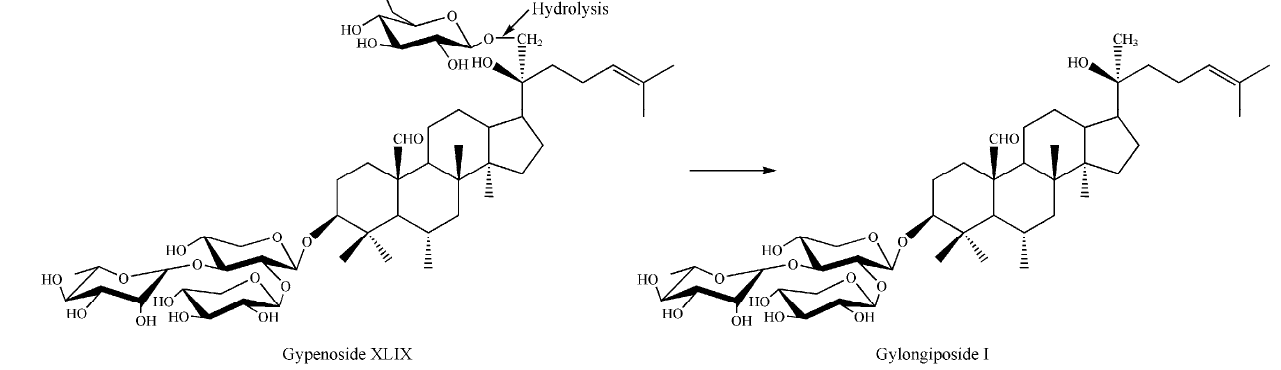
Figure 5. The biotransformation pathway of gypenoside XLIX by using the recombinant enzyme.